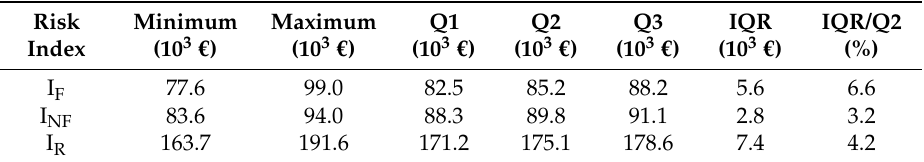
Table 4. Values of the minimum, maximum, first (Q1), second (Q2), third (Q3) quartiles, the interquartile range (IQR), and the relative value of the IQR against Q2, for the dam failure (I F ), non-failure (I NF ), and the global (I R ) risk